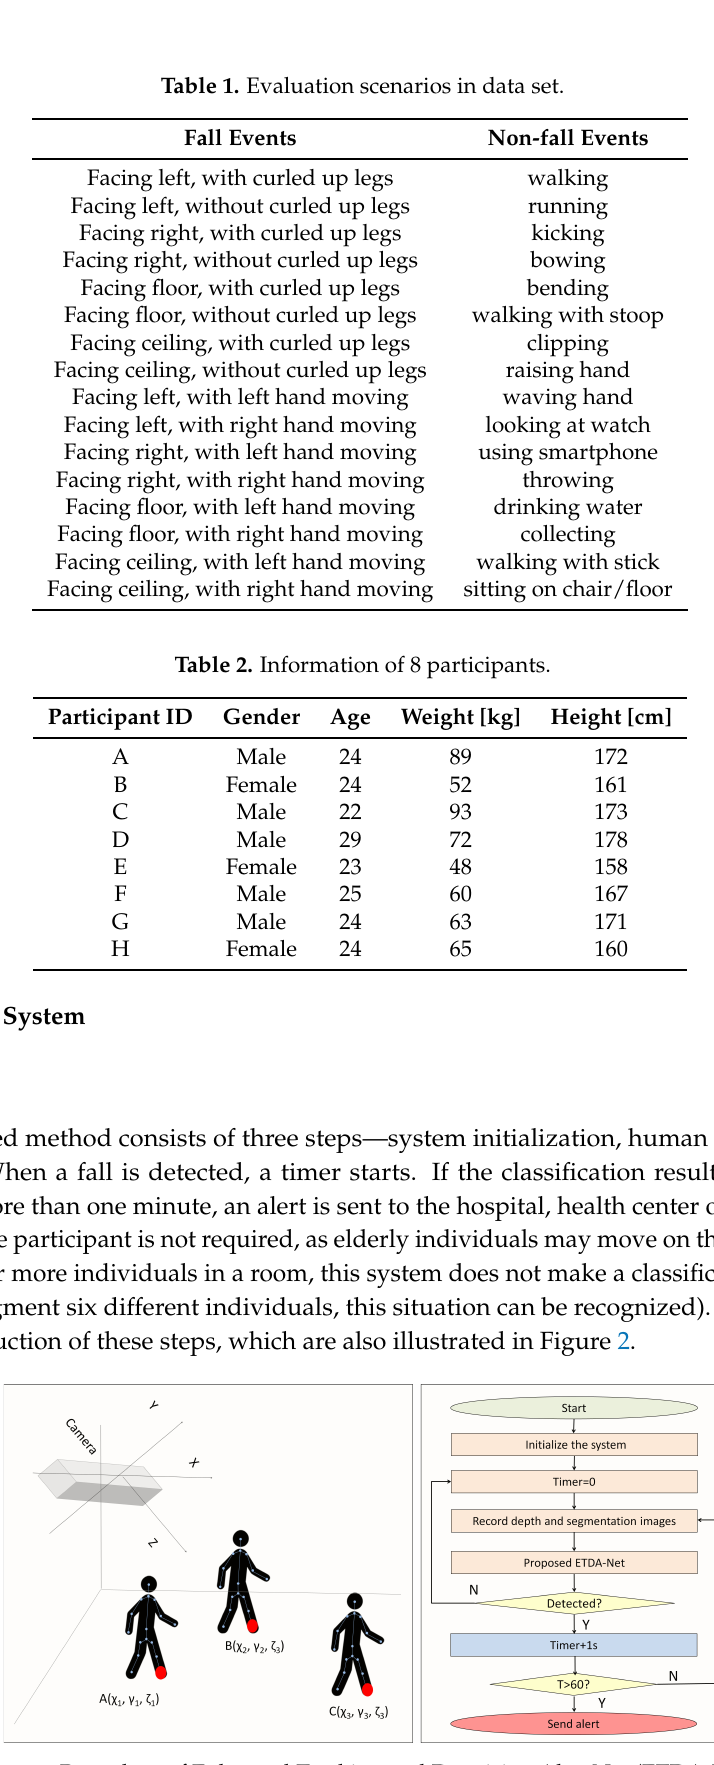
Figure 2. Procedure of Enhanced Tracking and Denoising Alex-Net